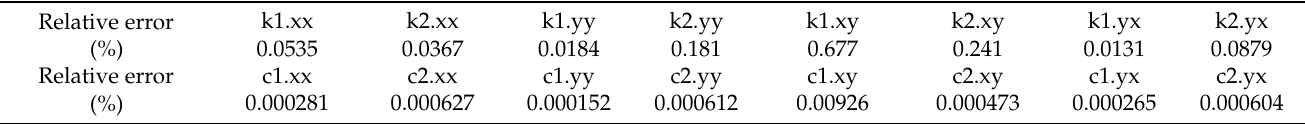
Table 12. The biggest relative identification error using